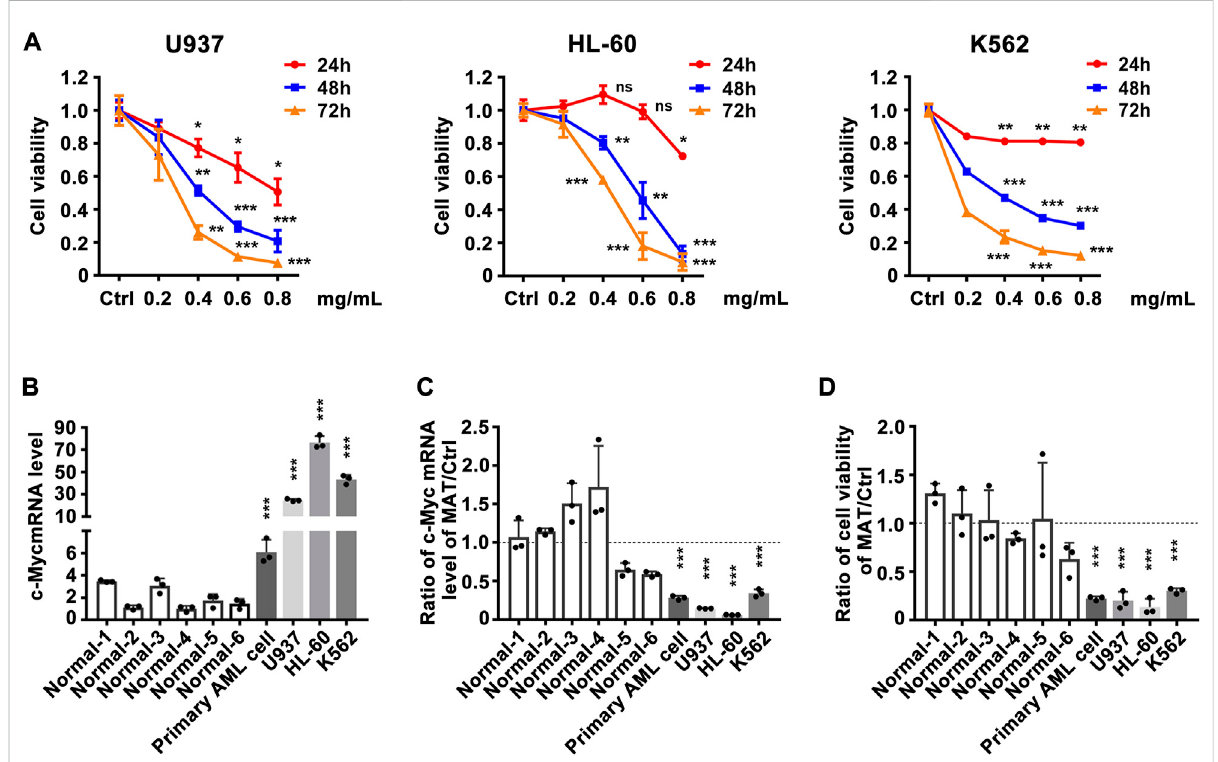
FIGURE 2 The inhibitory effect of matrine on the proliferation of myeloid leukemia cell lines is related to the expression inhibition of c-Myc. (A) Effects of matrineonproliferationofmyeloidleukemiacelllines.U937,HL-60andK562celllinesweretreatedwithdifferentconcentrationsofmatrinefor24h, 48 h and 72 h, respectively, and then subjected to CCK-8 assay. (B) Comparison of c-Myc expression levels between normal peripheral blood mononuclearcells(PBMCs),primaryleukemiacellsandmyeloidleukemiacelllines. (C) Comparisonoftheinhibitoryeffectofmatrineonc-Myc expression in PBMCs, primary leukemia cells and myeloid leukemia cell lines. (D) Comparison of the inhibitory effect of matrine on proliferation in PBMCs,primaryleukemiacellsandmyeloidleukemiacelllines.c-MycmRNAlevelsweredetectedbyqPCR (B,C) .CellviabilitywasdetectedbyCCK- 8assay (D) . β -actin wasused asan internal control.Data are shownas mean± SEMofthree independentlytriplicates and unpaired t-testwascarried out to detect signi fi cance (B – D) . ns, * p < 0.05, ** p < 0.01, *** p < 0.001 vs. Ctrl (A) or the mean of six normal subjects (B – D) . Ctrl, control; ns, signi fi cance; Normal 1-6, normal subjects, AML, Acute Myeloid